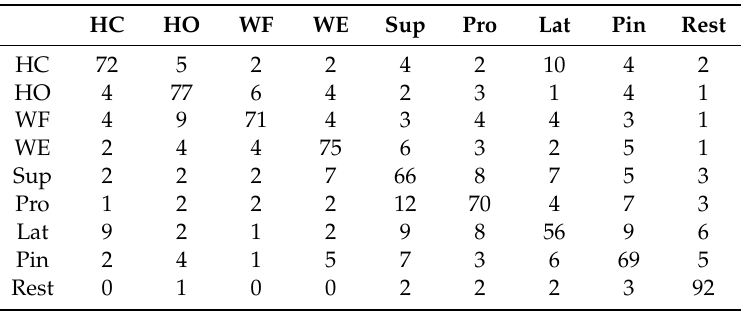
Table 3. Confusion matrix based on within-session calibration (the mean across the two days have been calculated) using linear discriminant analysis. All values are in percent and presented as the mean across participants. HC (Hand Close), HO (Hand Open), WE (Wrist Extension), WF (Wrist Flexion), Sup (Supination), Pro (Pronation), Lat (Lateral Grasp), and Pin (Pinch Grasp). HC